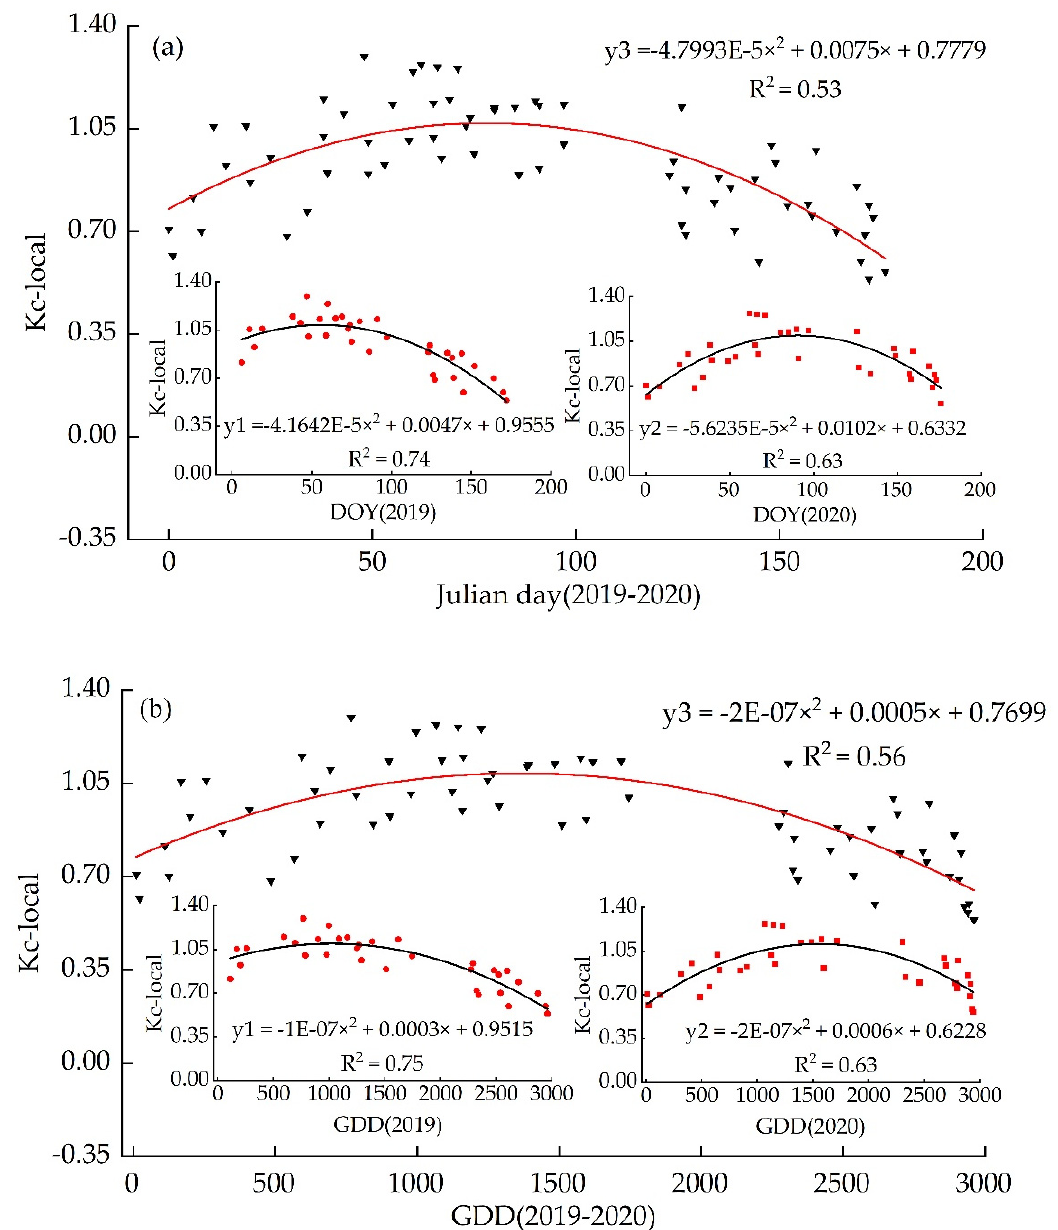
Figure 5. Variation of crop coefficient, K c-local , with ( a ) Julian day and ( b ) GDD (growing degree days) in 2019 and 2020.